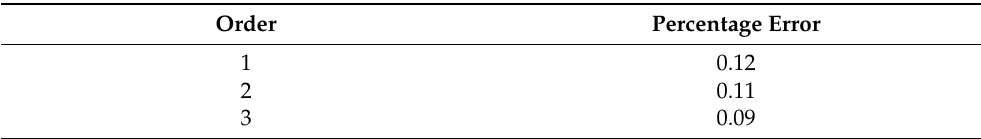
Table 3. Numerical integration errors associated with the mean annual pre-catXL loss estimates for different orders (presented in Figure 5). Column 1 displays the occurrence loss order, and Column 2 gives the numerical integration errors for each pre-catXL mean loss estimate. Order Percentage Error 1 0.12 2 0.11 3